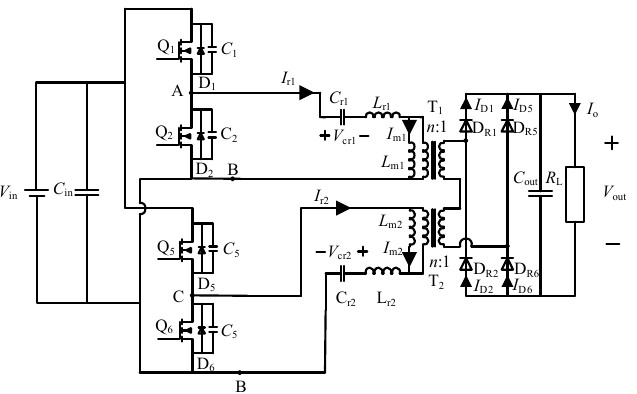
Figure 6. Equivalent circuit diagram of the half ‐ bridge inverter mode.